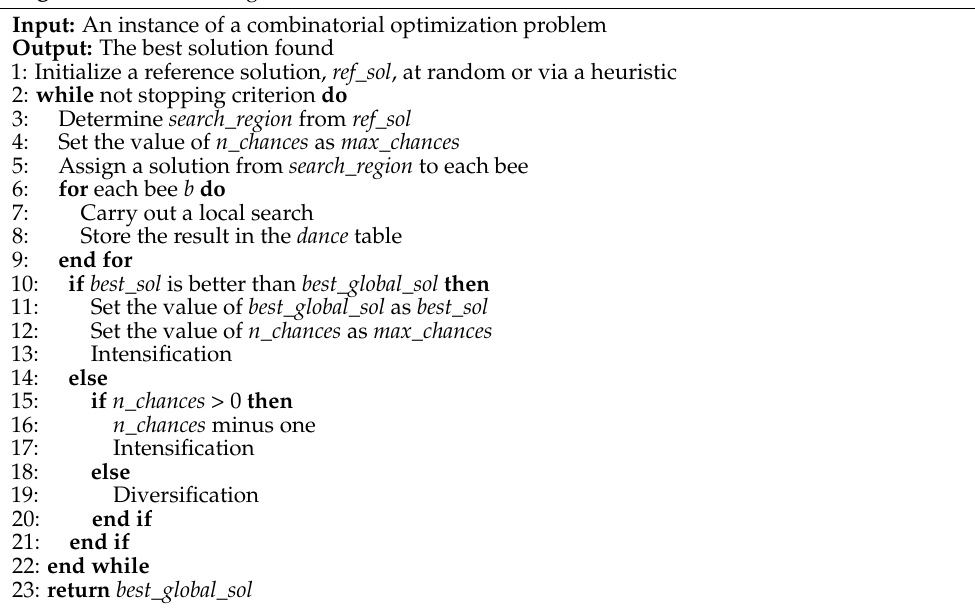
Algorithm 1. Overall algorithm flow for BSO and